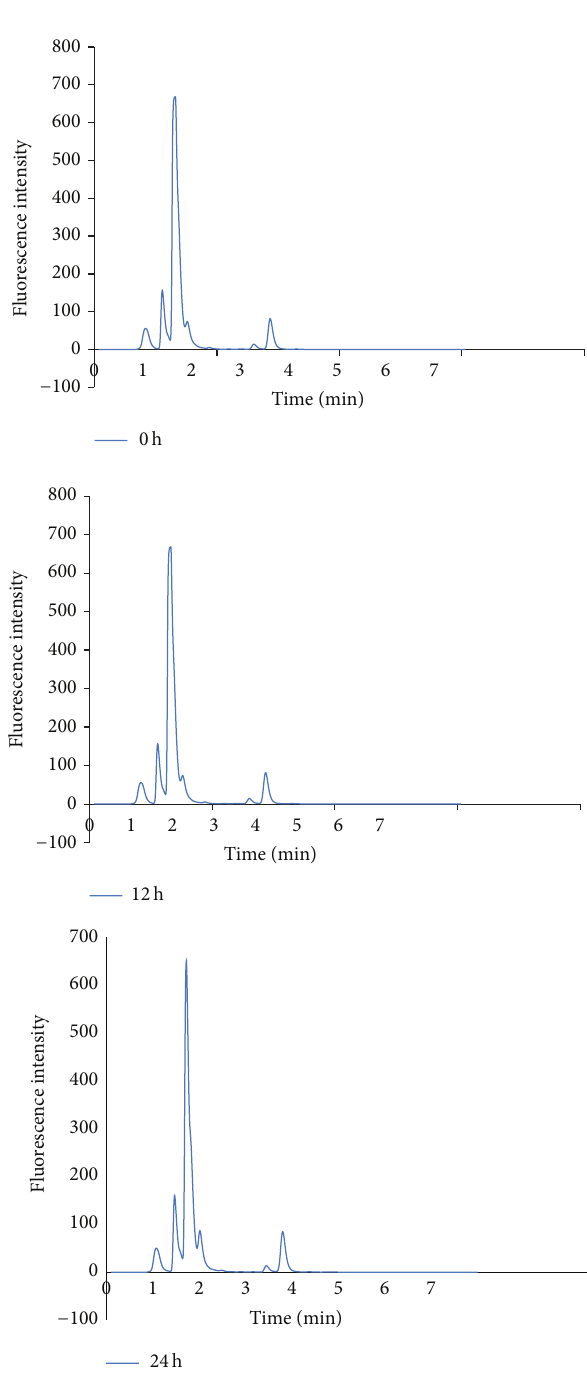
Figure 7: Stability of memantine fluorescent derivative in 4 h. HPLC condition: see Section